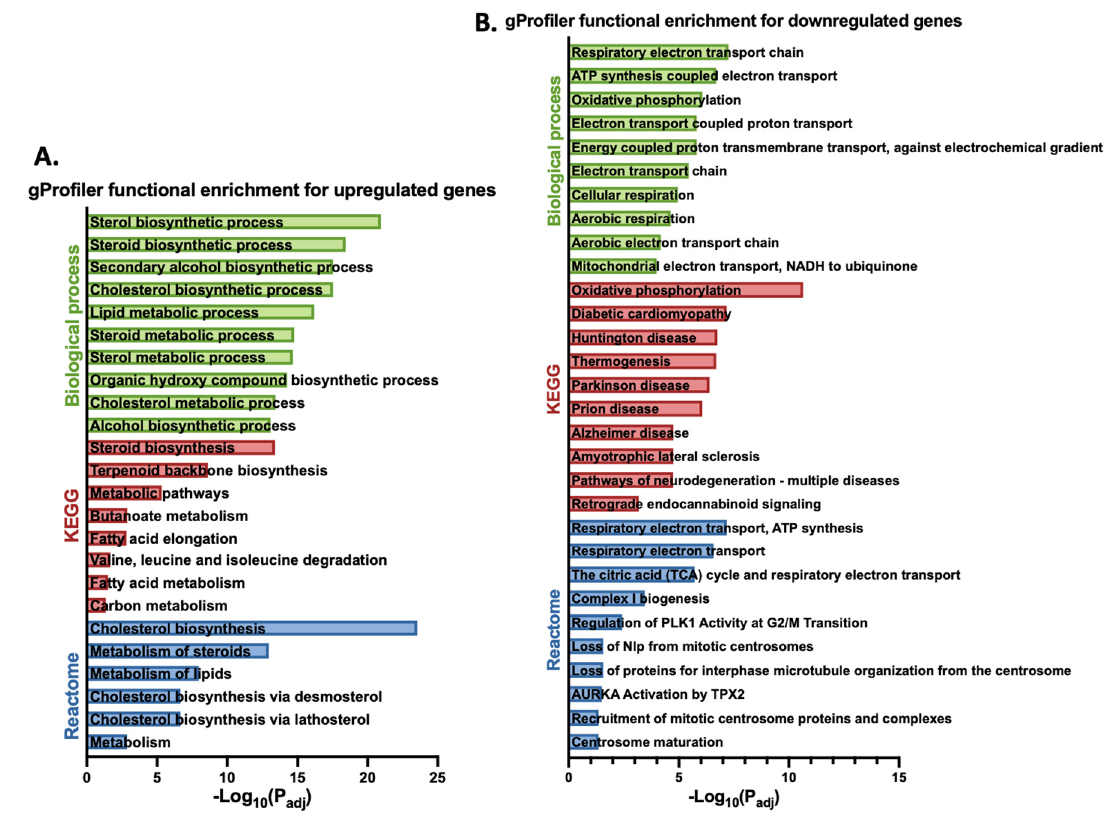
Figure 3. Functional enrichment for genes being upregulated ( A ) or downregulated ( B ) by gigantol in MA-10 Leydig cells according to the gProfiler analysis. Only the top 10 biological processes, KEGG pathways, and Reactome pathways are presented.